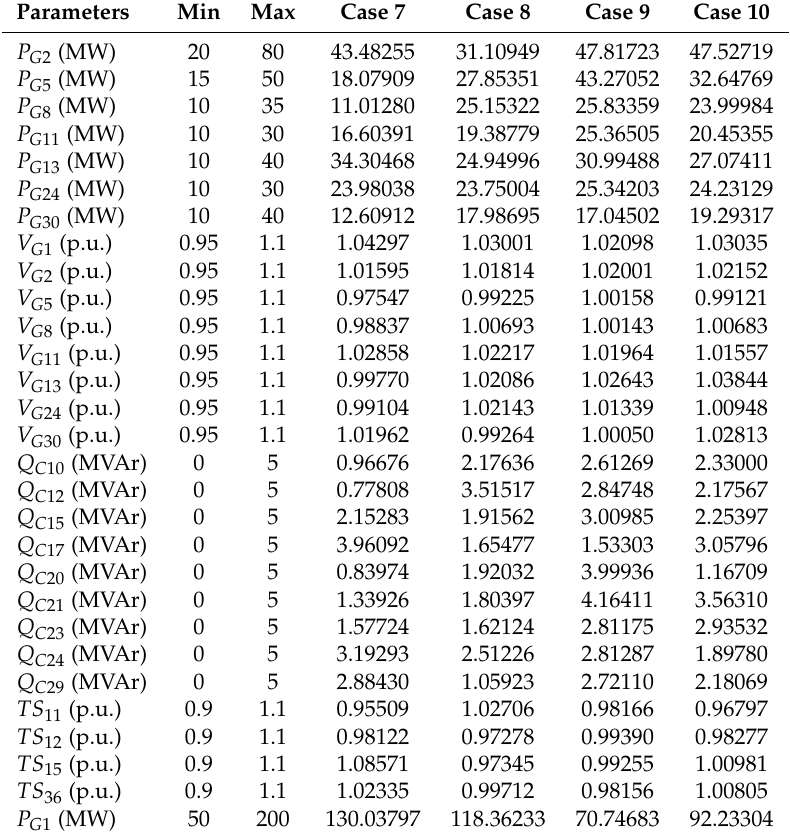
Table A10. Optimal solutions obtained by GROM for multi-objective OPF for IEEE 30-bus Modified (1).